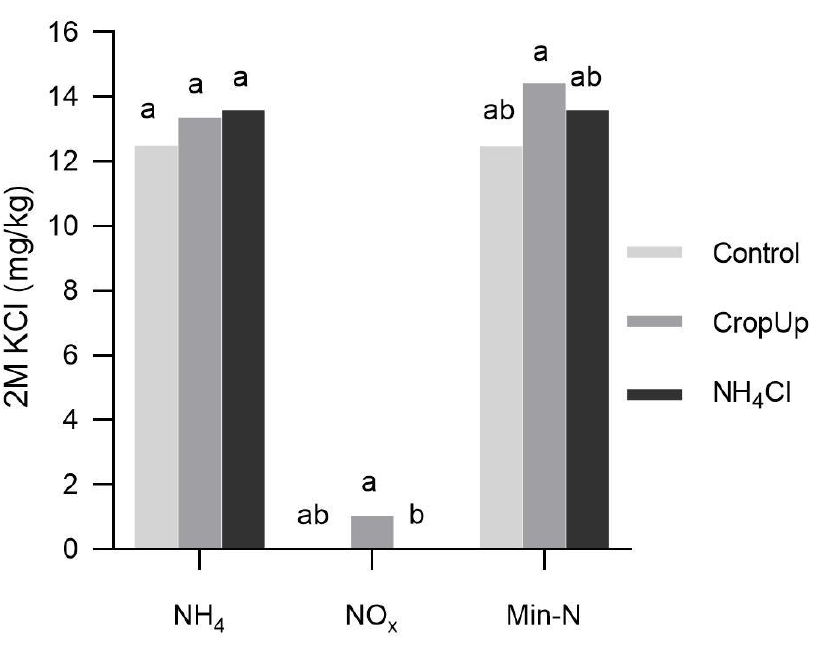
Figure 2. Mean 2M KCl-extractable NH 4 and NO x , and mineral N (NH 4 + NO x ) concentrations for the control, CropUp TM and NH 4 Cl treatments. Parameters with the same letter are not significantly different at p < 0.05 from each other.